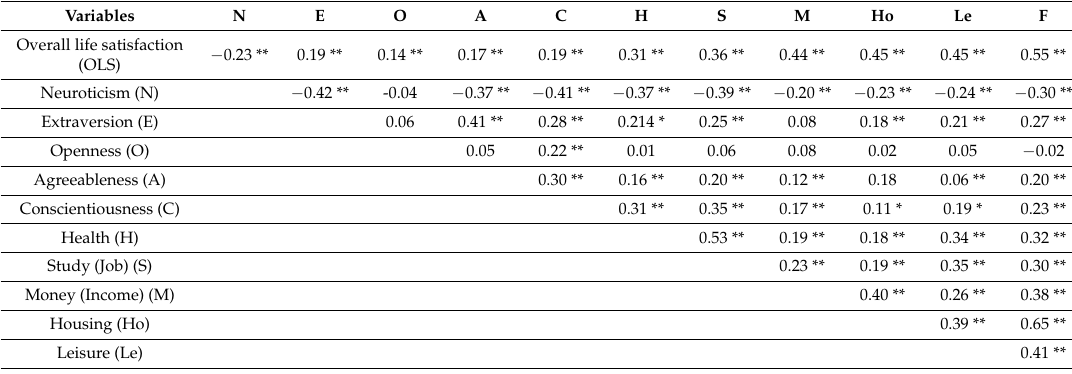
Table 12. Correlations of personality (BFI-10) and satisfaction variables for Survey 4. ( N = 488). Variables Overall life satisfaction